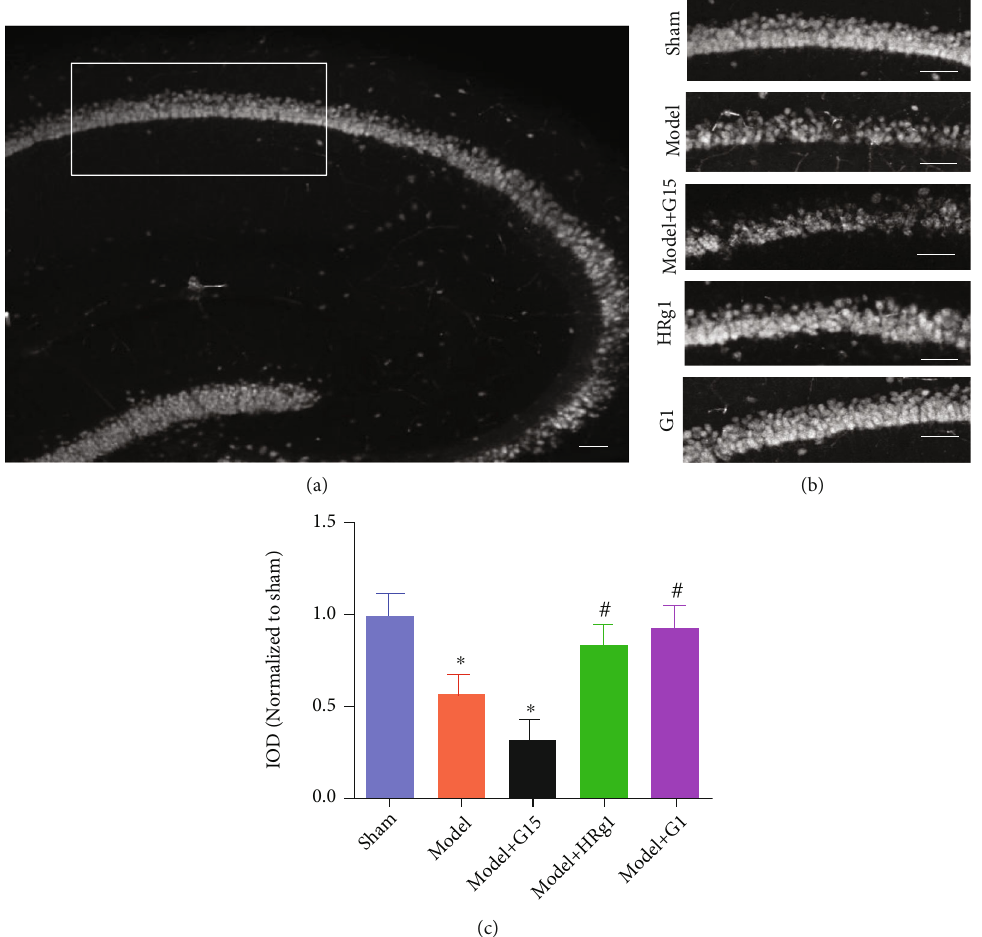
Figure 5: Ginsenoside Rg1 inhibited BCAS-induced loss of hippocampal neurons. (a) Observation area; (b) representative images of each group; scale bar: 50 μ m; (c) NeuN + cell counts. ∗ P < 0 : 05 , vs. the sham group, # P < 0 : 05 , vs. the model group ( N = 5 in each